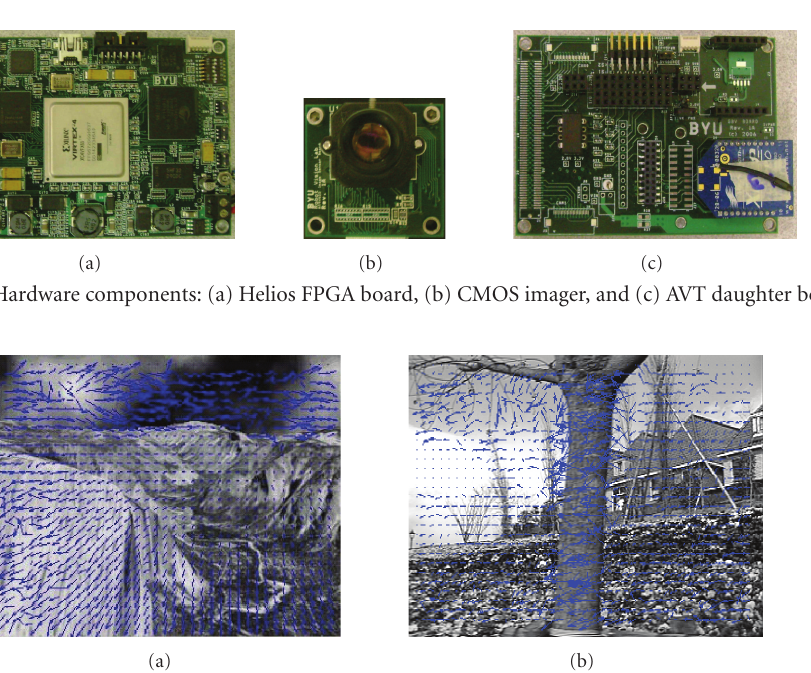
Figure 6: Result of synthetic sequences: (a) Yosemite, and (b) Flower